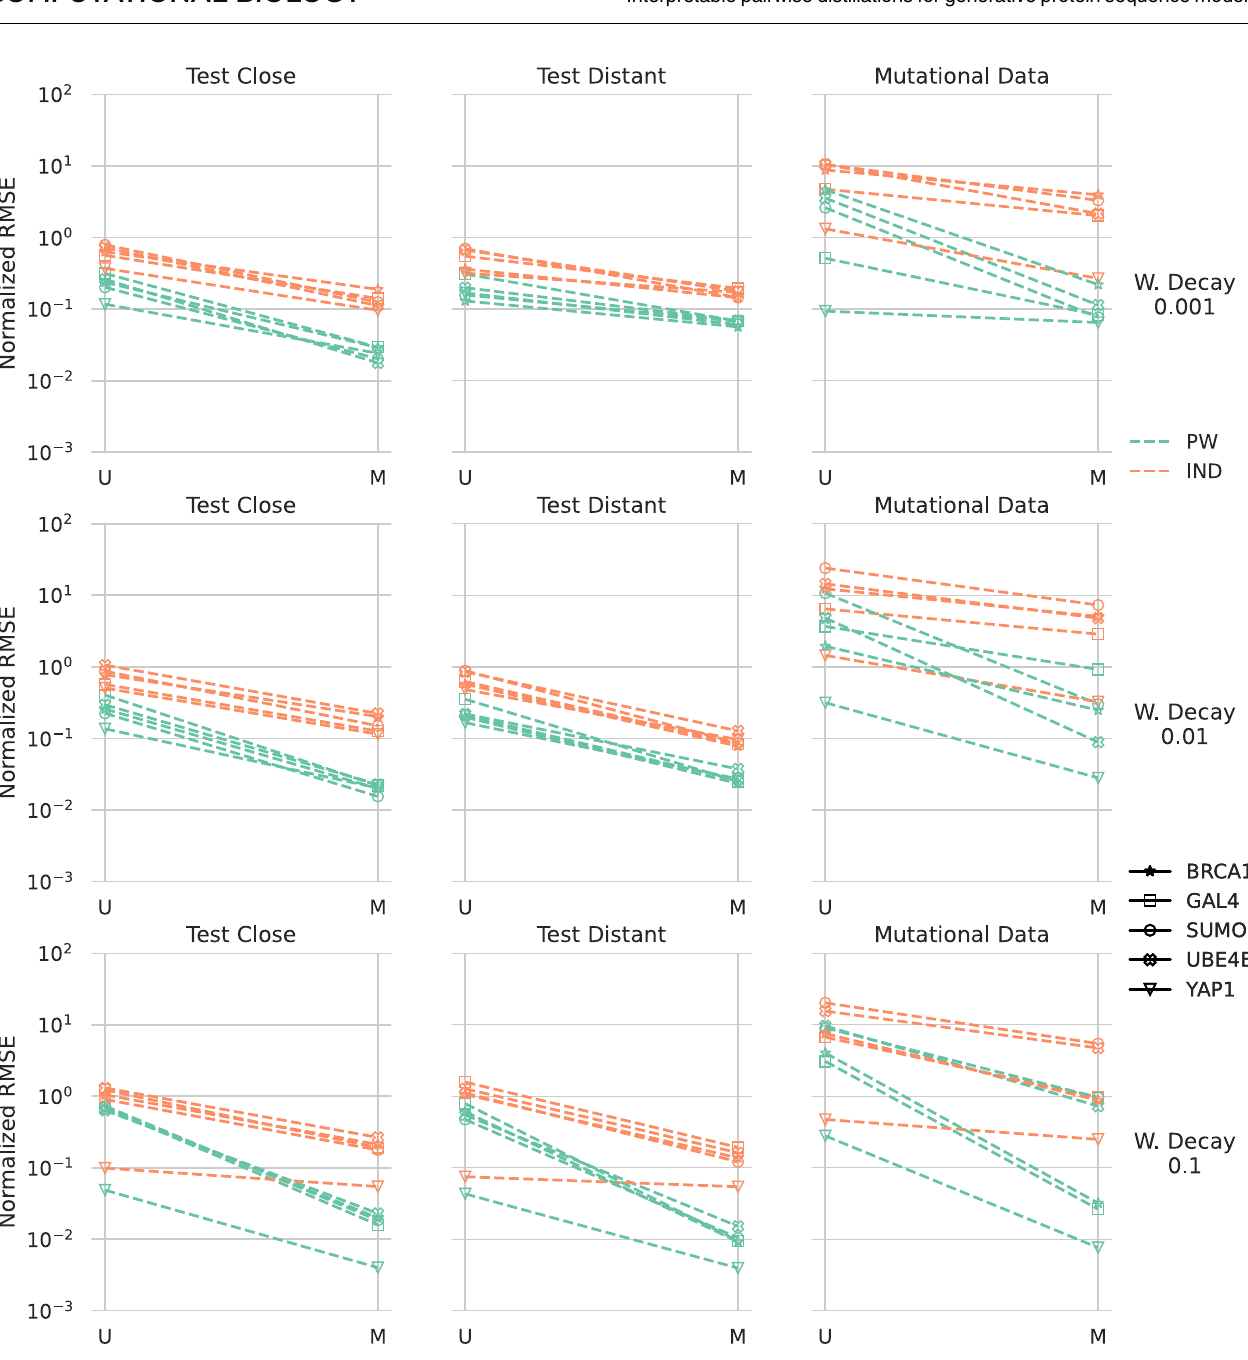
Fig 7. Errors in energies of the extracted pairwise and independent models with respect to the original VAE models. The three columns correspond to three different datasets: “Test Distant” corresponds to the 10% of sequences in the test set that have the largest distance to the training set in terms of minimum Hamming distance, “Test Close” to the remaining sequences. The right-most column corresponds to the sequences in the mutational datasets. The colors indicate whether the extracted model is an independent model (orange) or a pairwise model (green). Within every column, the left bar (U) corresponds to models extracted with samples from the uniform distribution, the right bar (M) to models extracted with samples from the distribution of the original models. The three rows correspond to different settings for weight decay during training. The error shown is the normalized root-mean squared error (see Eq 8. Note the logarithmic